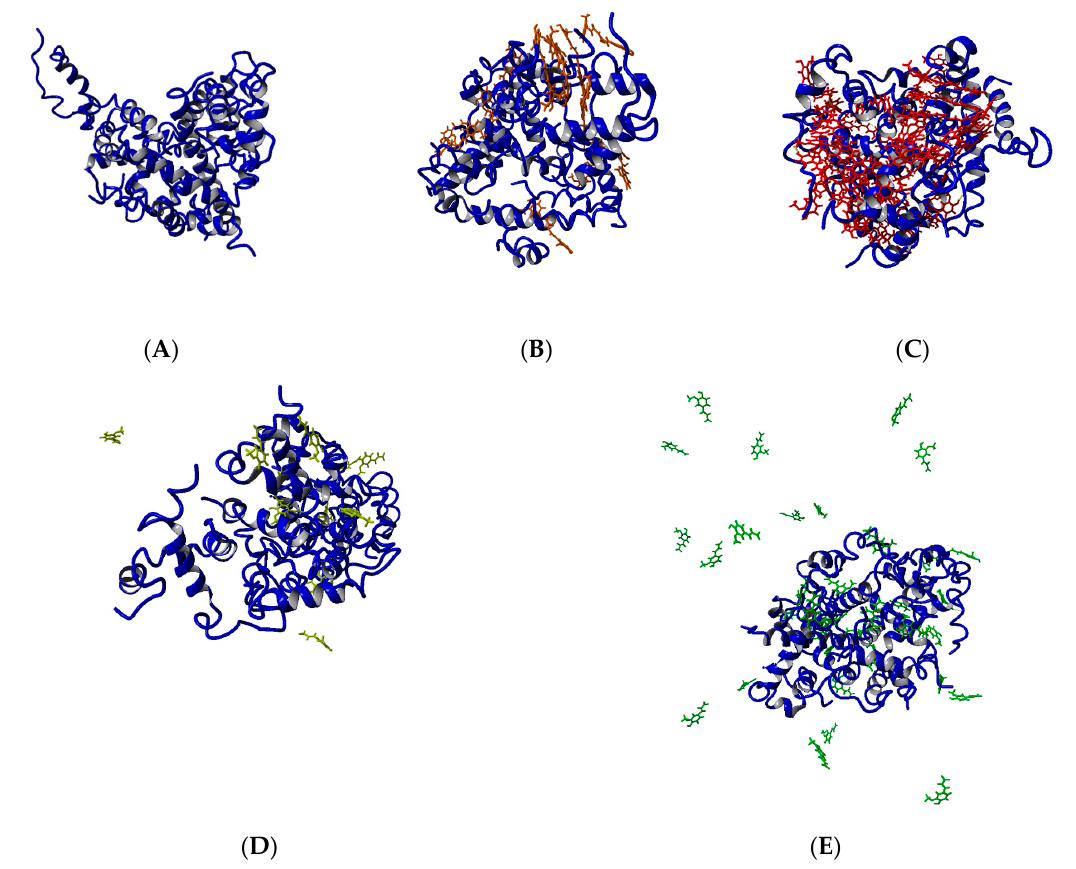
Figure 4. The modeled systems after 1 µ s molecular dynamics (MD) simulation: ( A ) 12 A β monomers; ( B ) 12 A β monomers and 12 CU molecules; ( C ) 12 A β monomers and 36 CU molecules; ( D ) 12 A β monomers and 12 FA anions; ( E ) 12 A β monomers and 36 FA anions.